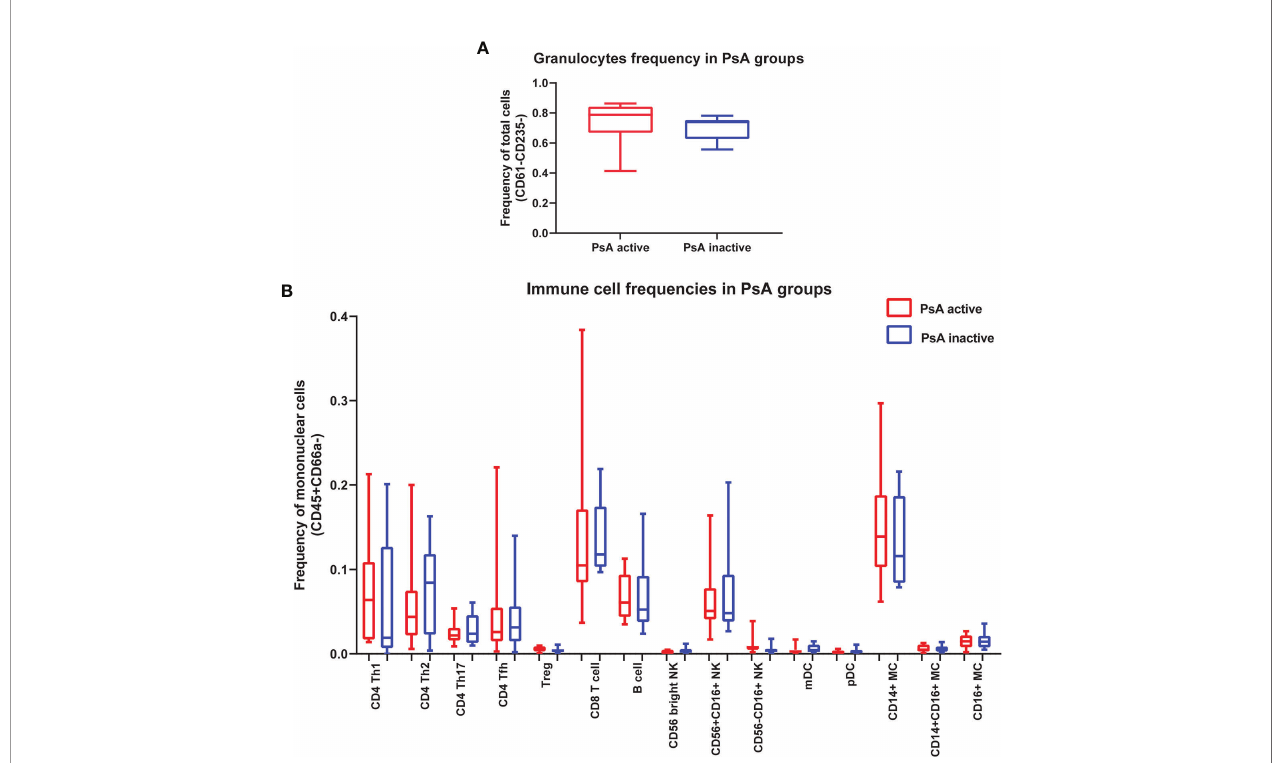
FIGURE 1 | No differences in immune cell frequencies in whole blood between patients with active or inactive PsA. (A) Frequency of granulocytes is expressed as frequency of leukocytes. (B) Frequencies of 15 immune cell subpopulations expressed as frequency of total mononuclear cells (CD45+CD66a-). Data are shown as box plots extending from the 25th to 75th percentiles, and the whiskers from the minimum to the maximum point; middle line represents the median. Samples from 15 active PsA patients and 12 inactive PsA patients were tested. Group to group comparison using unpaired t test with Welch ’ s correction, p>0.05 in all comparisons. Tfh, T follicular helper; mDC, myeloid Dendritic cell; pDC, plasmacytoid Dendritic cell; MC,